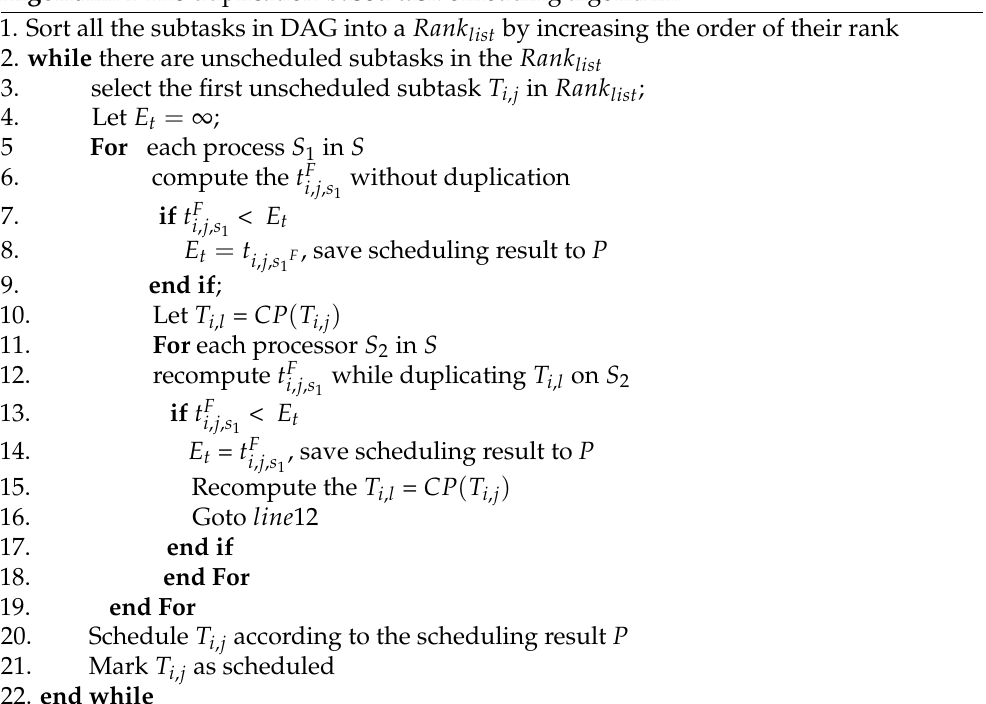
Algorithm 1 The duplication-based task offloading